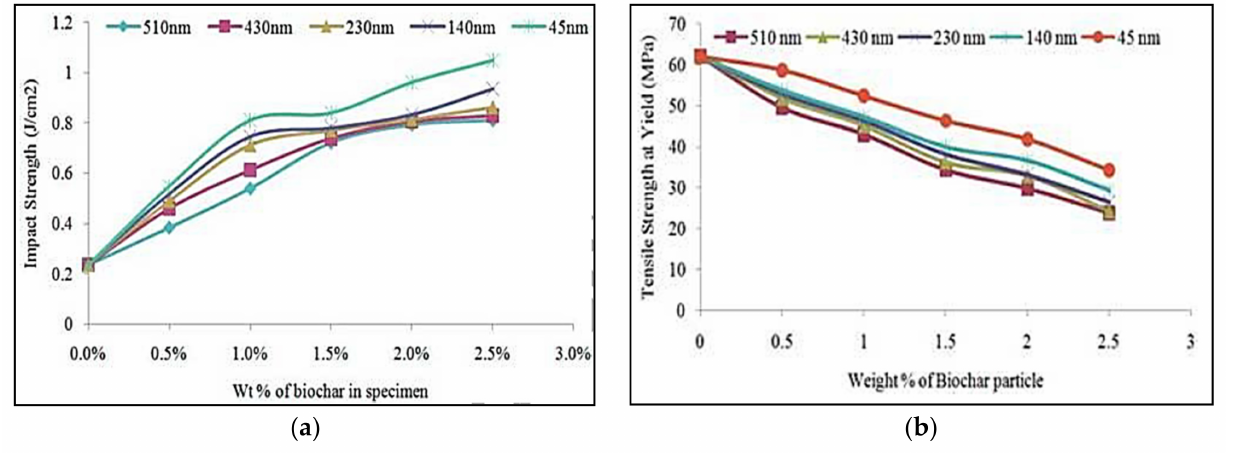
Figure 28. ( a ) Impact strength of composite material and ( b ) tensile test results of composite material